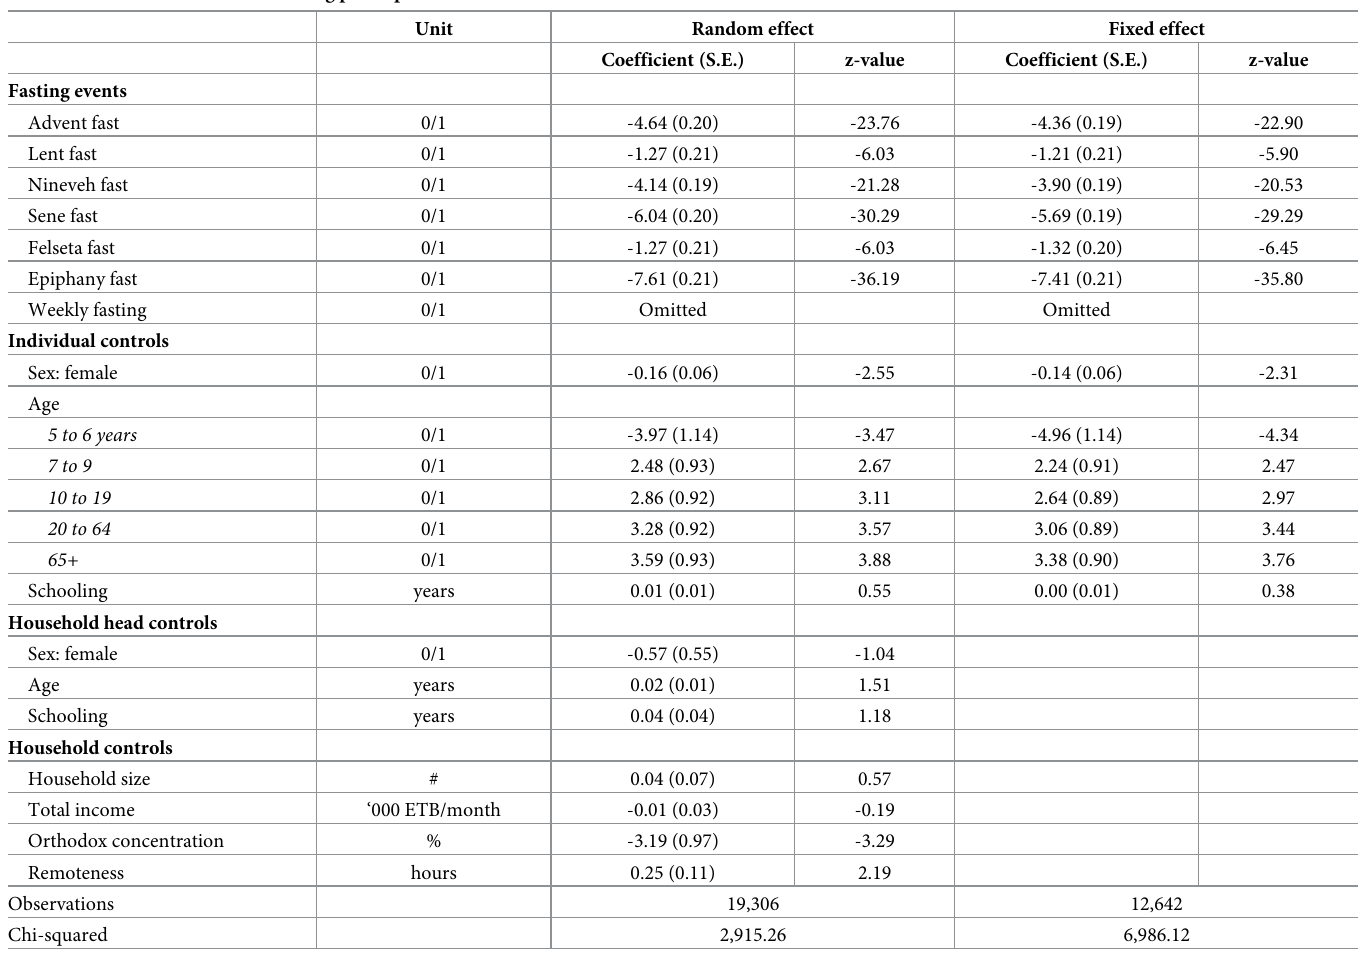
Table 6. Factors associated with fasting